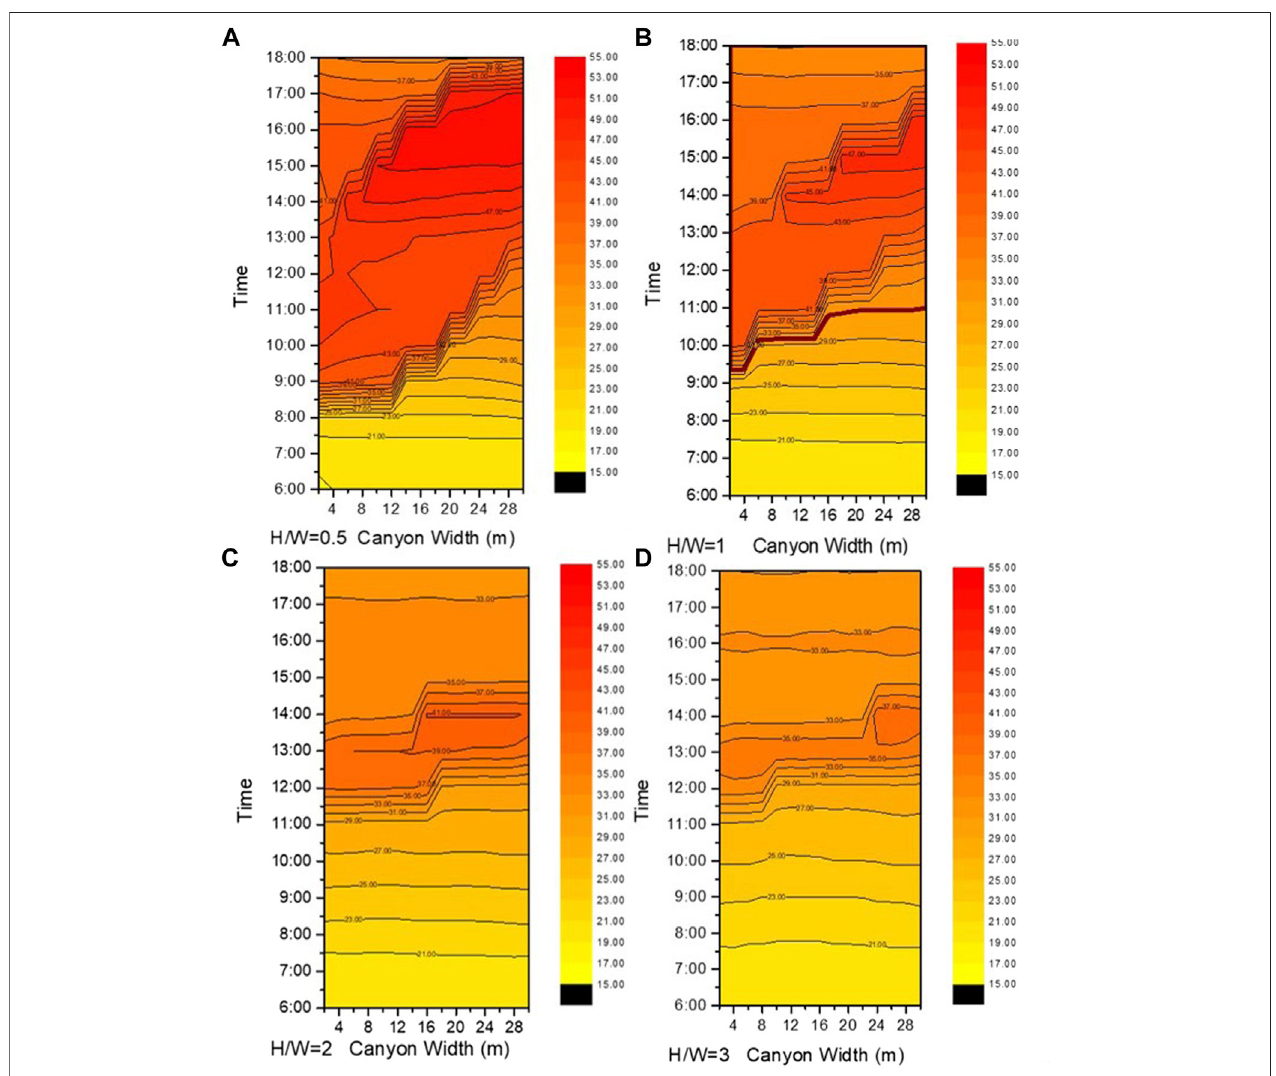
FIGURE7| TemporalandspacialvariationsinPETatthepedestrianlevelwithinthestreetcanyonsindifferentaspectratio-H/W=0.5 (A) ,H/W=1 (B) ,H/W=2 (C) and H/W = 1 (D) .